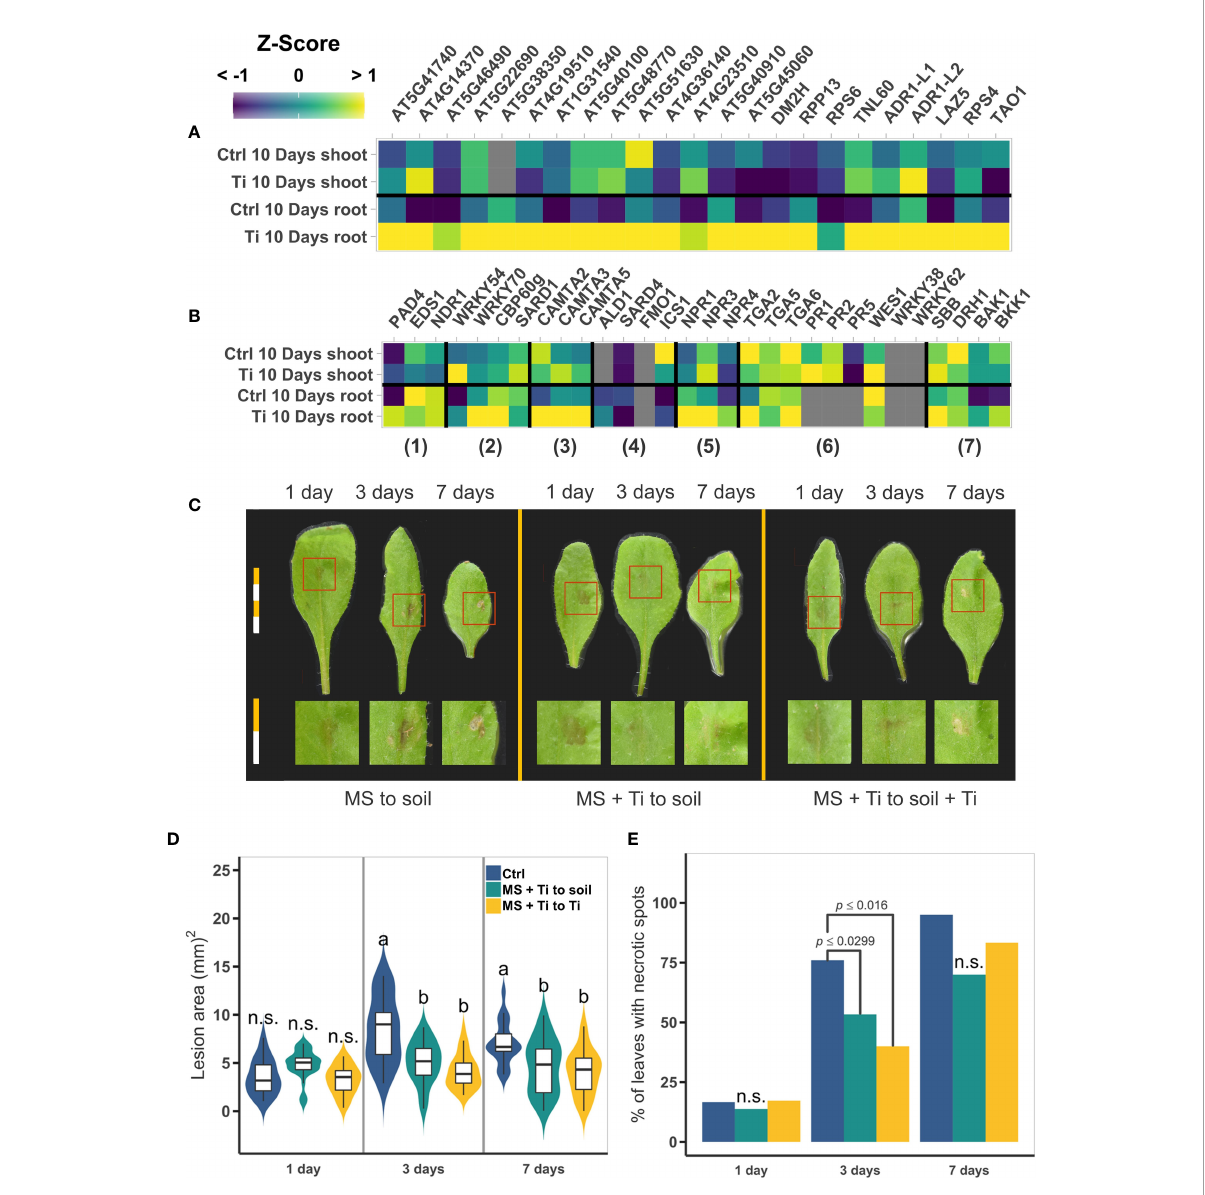
FIGURE 8 Effect of Titanium (Ti) on the expression of pathogen responsive genes and on Arabidopsis -Botrytis cinerea interaction. (A) Mean normalized expression levels of NBS-LRR receptors genes. (B) Mean normalized expression levels of salicylic acid (SA) and systemic acquired response related genes. Numbers bellow the heatmap indicate the function of the genes; 1) SA regulatory modules, 2) SA biosynthesis positive regulators, 3)